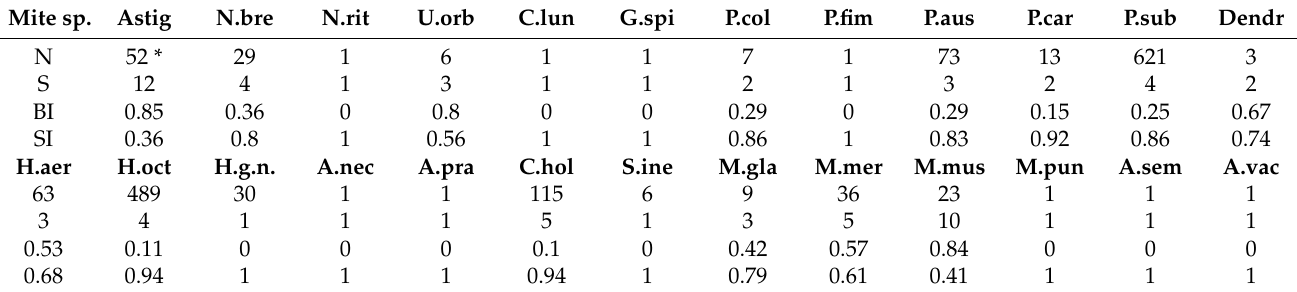
Table 1. Values of total number of host insects collected (N) for each species, number of host species for each species (S), result of the biodiversity index (BI) and result of the specificity index (SI). (*) Appearances, not number of mites. The abbreviations used are the same as in Figure